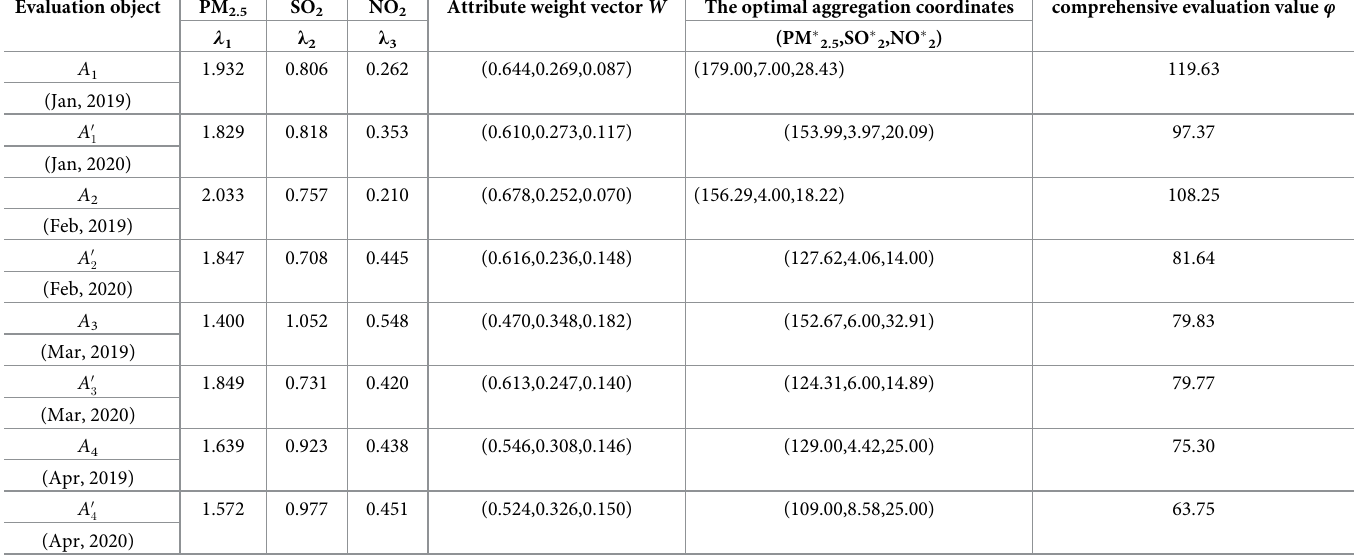
Table 1. Calculation